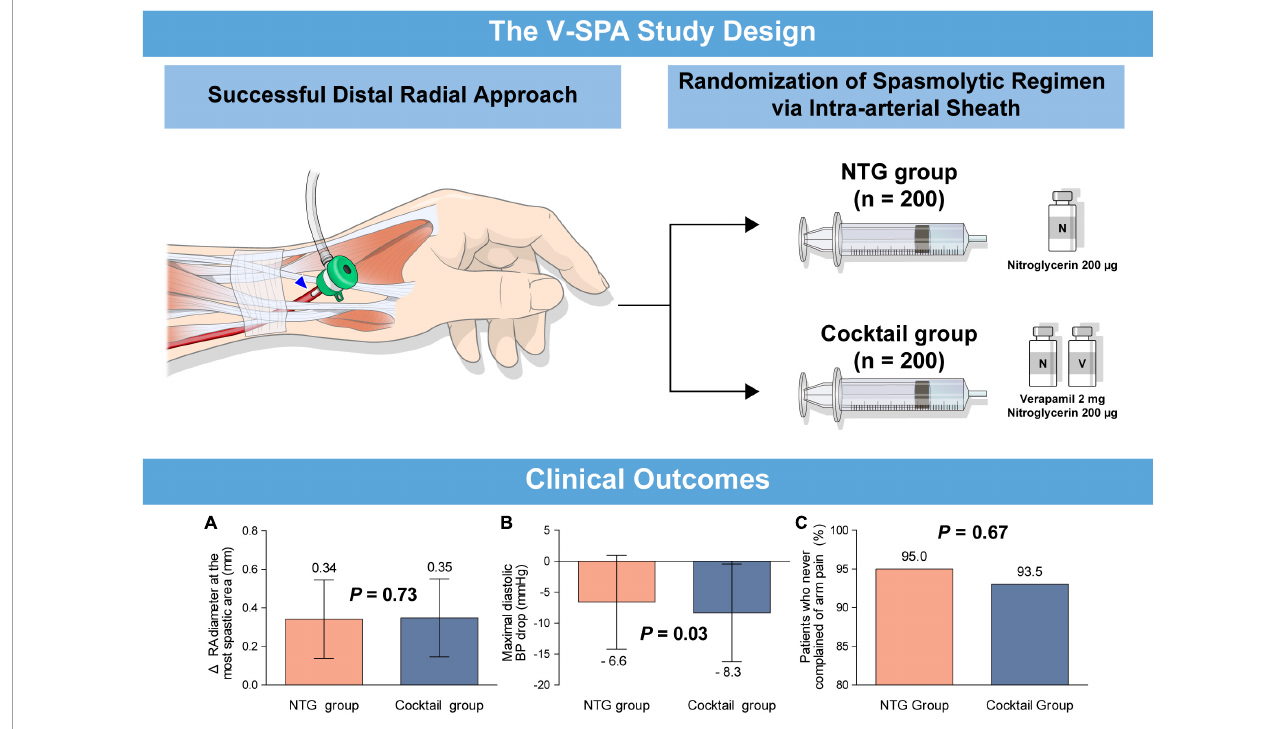
FIGURE4 (Visual abstract). Comparison of spasmolytic regimen (only NTG versus NTG plus verapamil) for prevention of radial artery spasm during the distal radial approach. A prospective, randomized, single-center trial, the V-SPA study, demonstrated that intra-arterial injection of NTG as a single agent is effective and safe in the prevention of RAS during coronary catheterization via the DRA compared with a cocktail regimen of NTG plus verapamil. (A) Changes of radial artery diameter at the most spastic area, (B) maximal diastolic blood pressure drop, (C) patients who never complained of arm pain. DRA, distal radial approach; NTG, nitroglycerin; RAS, radial artery spasm; V-SPA, comparison of spasmolytic regimen for the preVention of radial artery SPasm during coronary angiography via the distal radial